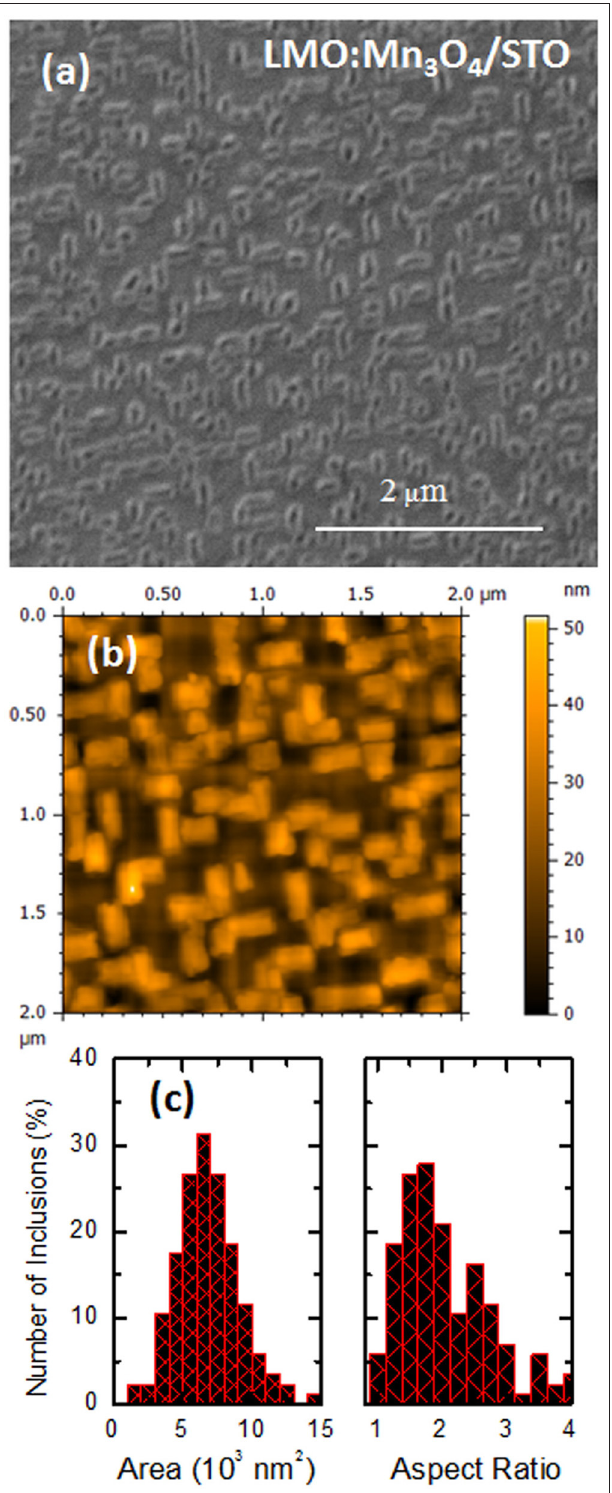
FIGURE 1 | Surface morphology of 40nm thick LMO nanocomposite films grown on top of STO substrate (A) SEM image (B) AFM image (C). Statistical distribution analysis of size and shape of the Mn 3 O 4 inclusions observed in SEM